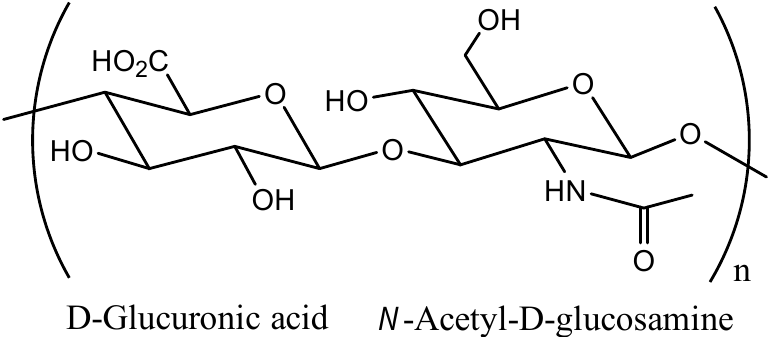
Figure 1. Chemical structure of Hyaluronic acid.